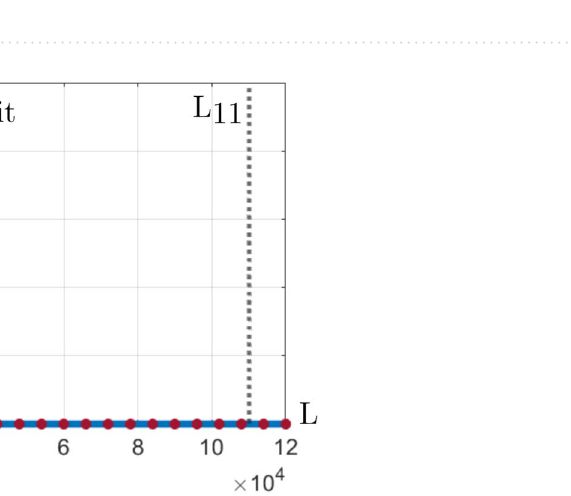
# A # A # 3 (yellow line) of the System (6) as function of L . 1 (blue line), 2 (red line), and